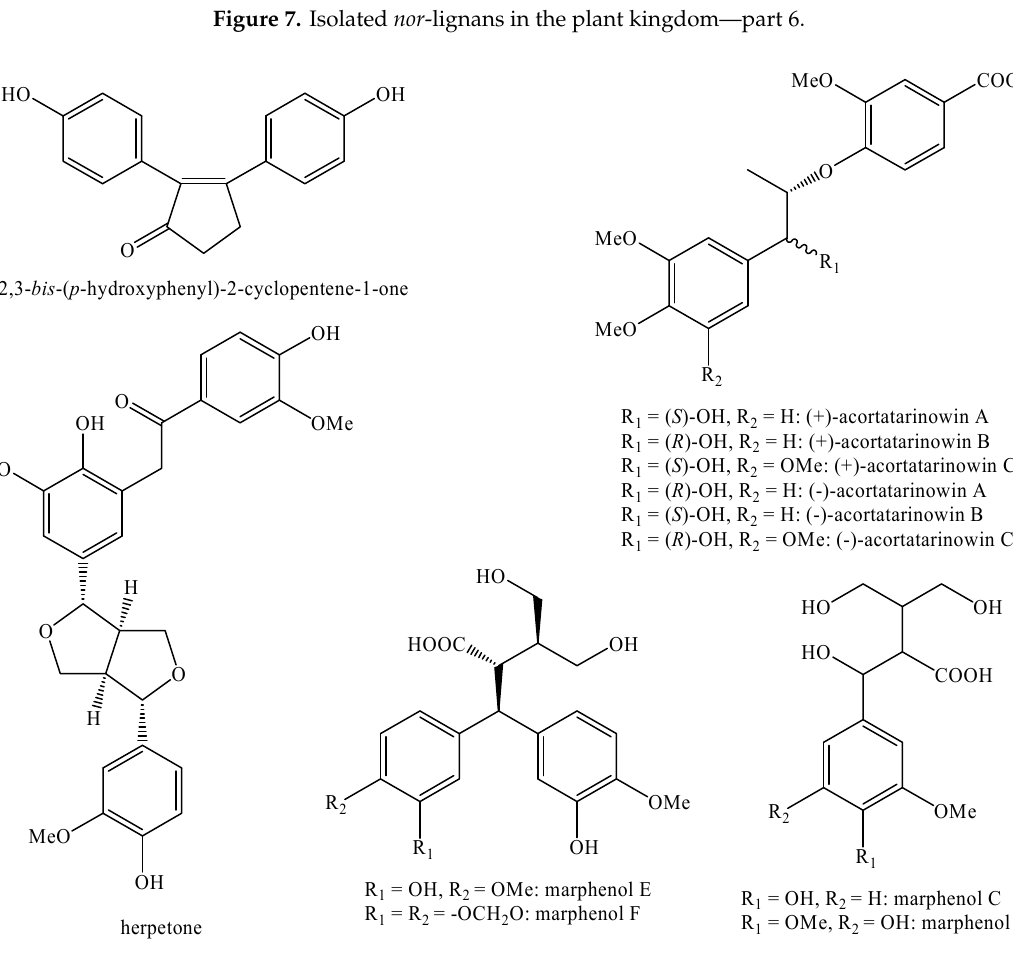
Figure 8. Isolated nor -lignans in the plant kingdom—part 7.